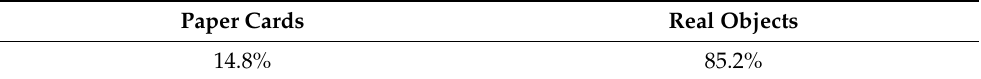
Table 7. Distribution of the responses to the question “Do you prefer to play the game with real objects or with cards?”.